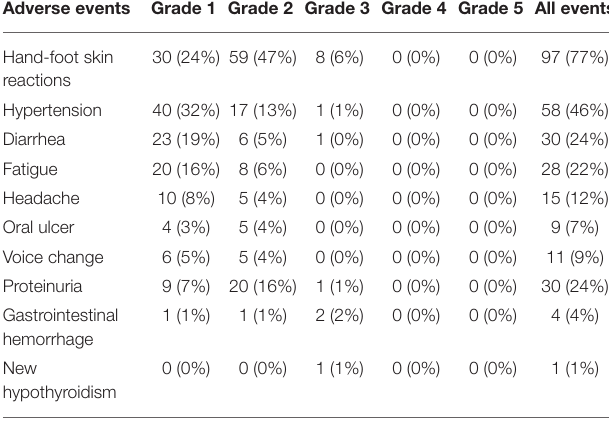
TABLE 4 | Adverse events related to apatinib in the TACE–apatinib group before PSM